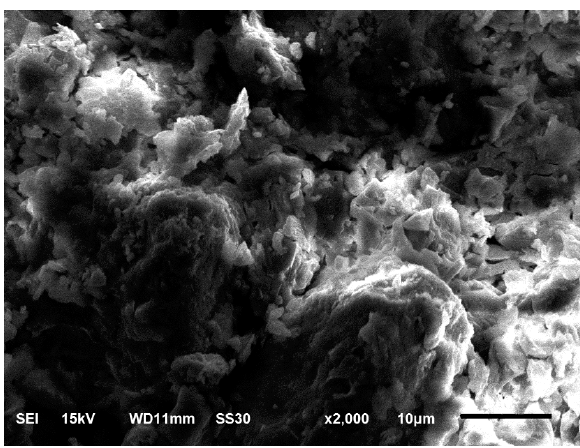
Figure 1. Scanning electron microscope image of tested sandstone.